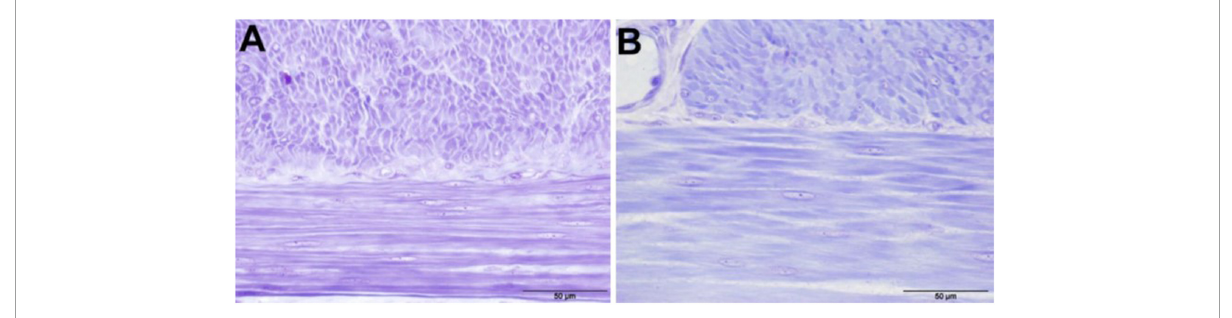
FIGURE3 Cell nuclei in the tunica muscularis of the jejunum of animals in both groups, 400 × magnification (toluidine blue stained) (A) CON; (B) PL.